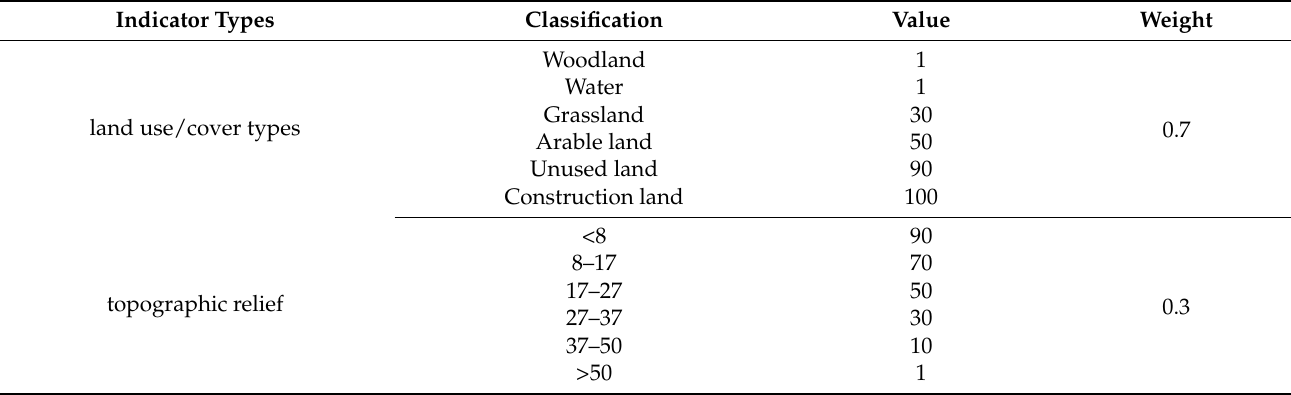
Table 1. Ecological resistance